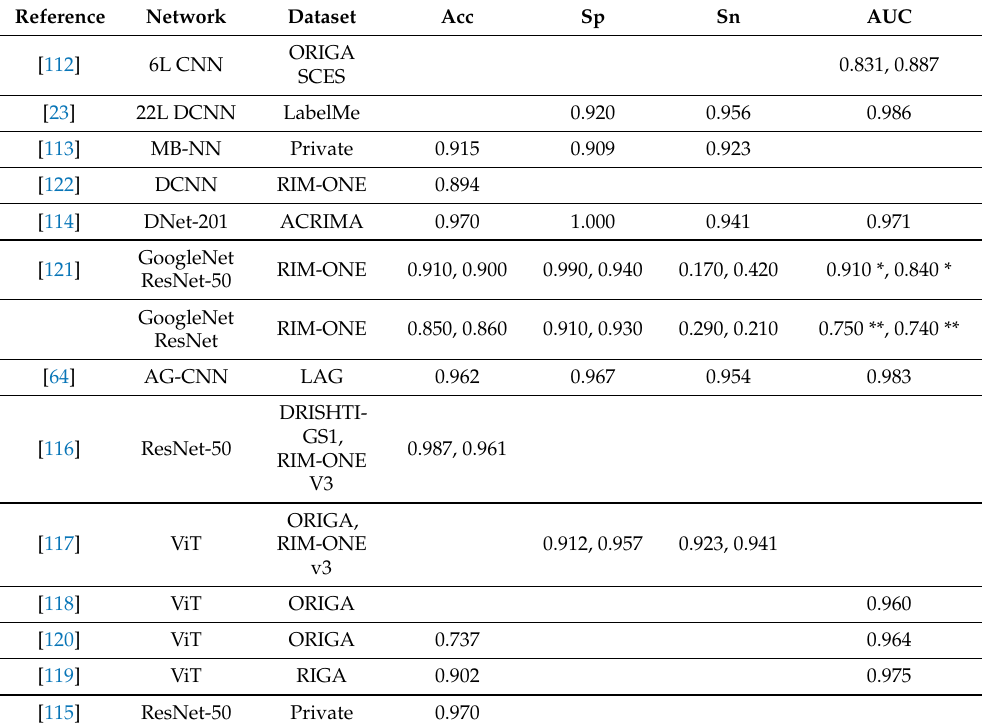
Table 5. Summary of DL Methods for Glaucoma